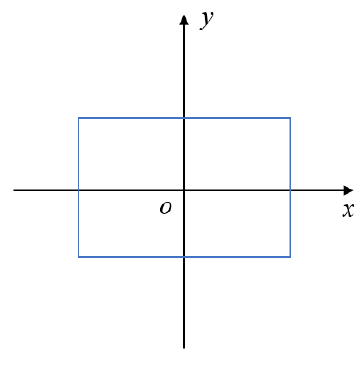
Figure 2. Rectangular pupil. According to Figure 2, the rectangular pupil function